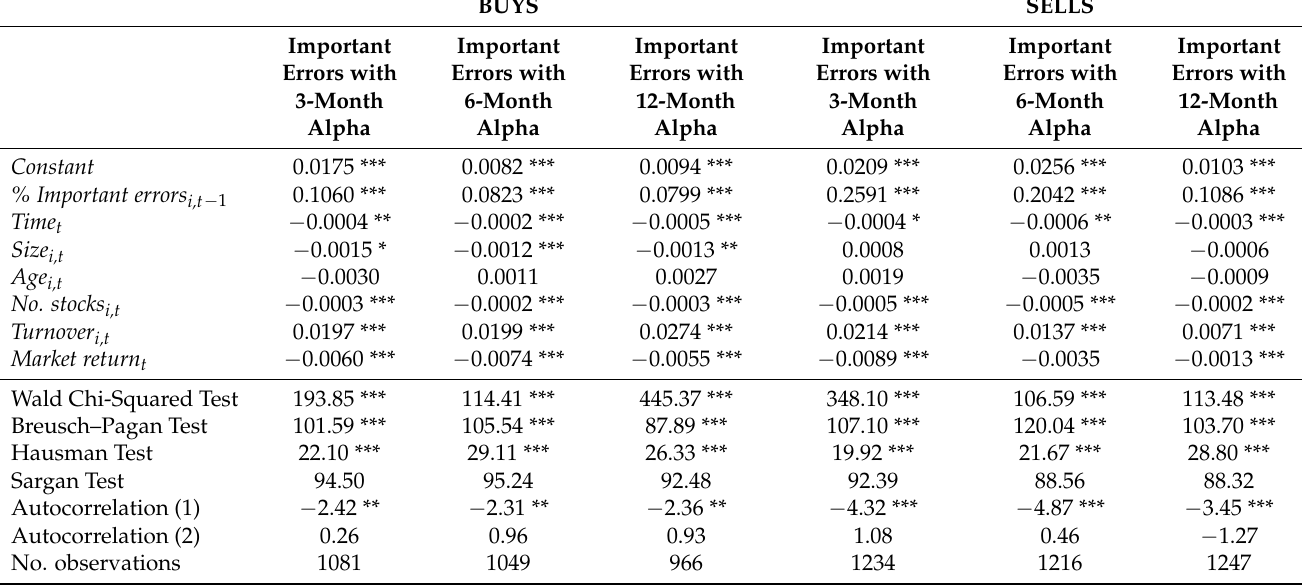
Table 3. Learning results in Euro domestic equity mutual funds. This table presents the results of Equation (14) for Euro domestic equity mutual funds from January 2000 to March 2014. The learning results are divided into buys and sells after considering different time horizons to compute the subsequent effect of these errors: 3-month alpha, 6-month alpha, and 12-month alpha. The dependent variable % Important errors i,t is the percentage of important errors for fund i in year t . The